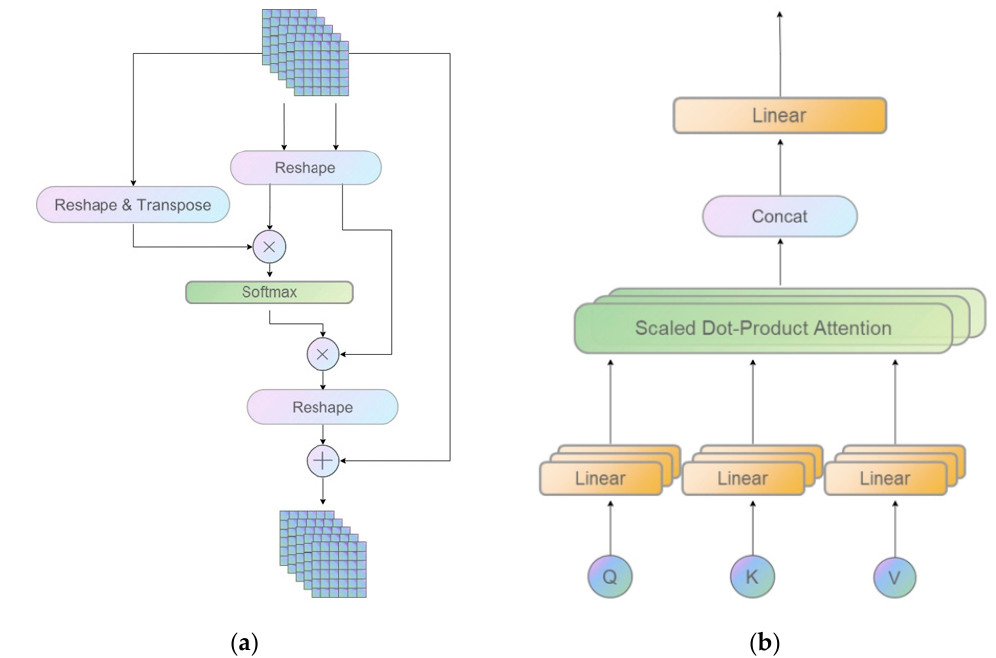
Figure 3. ( a ) The structure of the channel attention mechanism applied in the AD blocks in the first three layers, and ( b ) the structure of the multihead self-attention mechanism applied in the last-layer AD block.